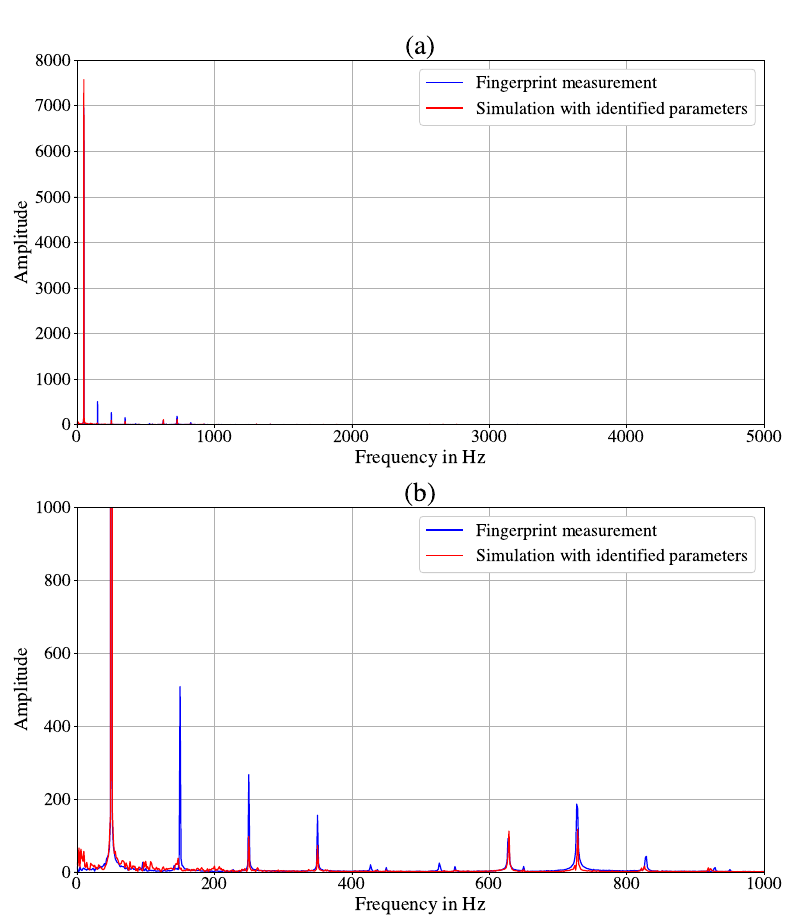
Figure 8. Comparison of the frequency spectra for one of the three stator currents from the fingerprint measurement and the simulation with the parameterized model: ( a ) complete frequency spectrum; ( b ) zoom of the frequency spectrum into the significant range (0 to 1000